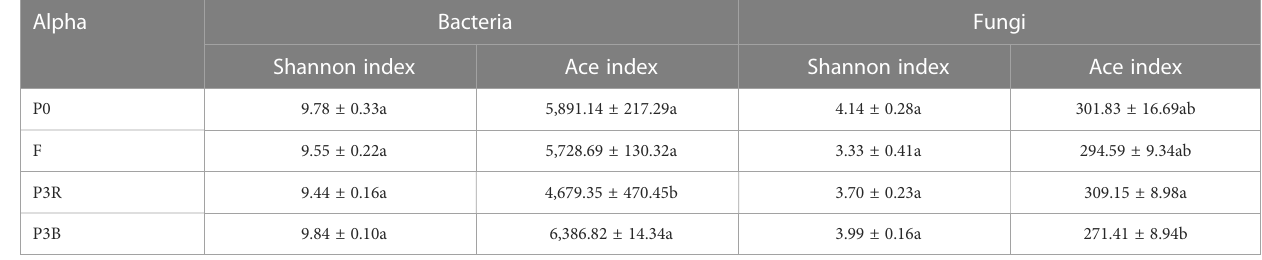
TABLE 2 Alpha diversity indices.